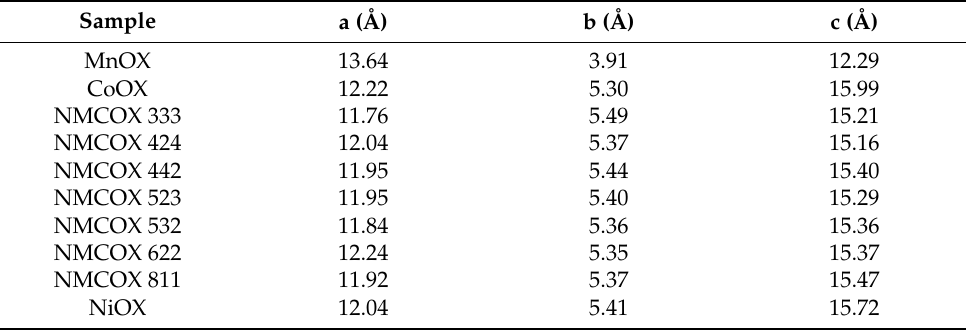
Figure 1. X-ray diffractometer patterns of the oxalate precursor; ( a ) MnOX, ( b ) CoOX, ( c ) NMCOX 333, ( d ) NMCOX 424, ( e ) NMCOX 442, ( f ) NMCOX 523, ( g ) NMCOX 532, ( h ) NMCOX 622, ( i ) NMCOX 811, and ( j ) NiOX. Table 2. Lattice parameter of the oxalate